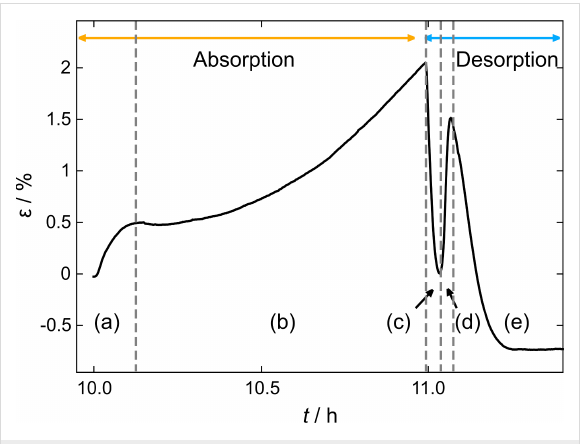
Figure 3: Enlarged view of Figure 2: Strain ε as a function of time t for electrochemical hydrogen absorption in nanoporous palladium at an anodic potential of − 1.0 V followed by desorption at − 0.4 V in 1 M KOH. Labelled regions are discussed in the text (regions (d) and (e): strain